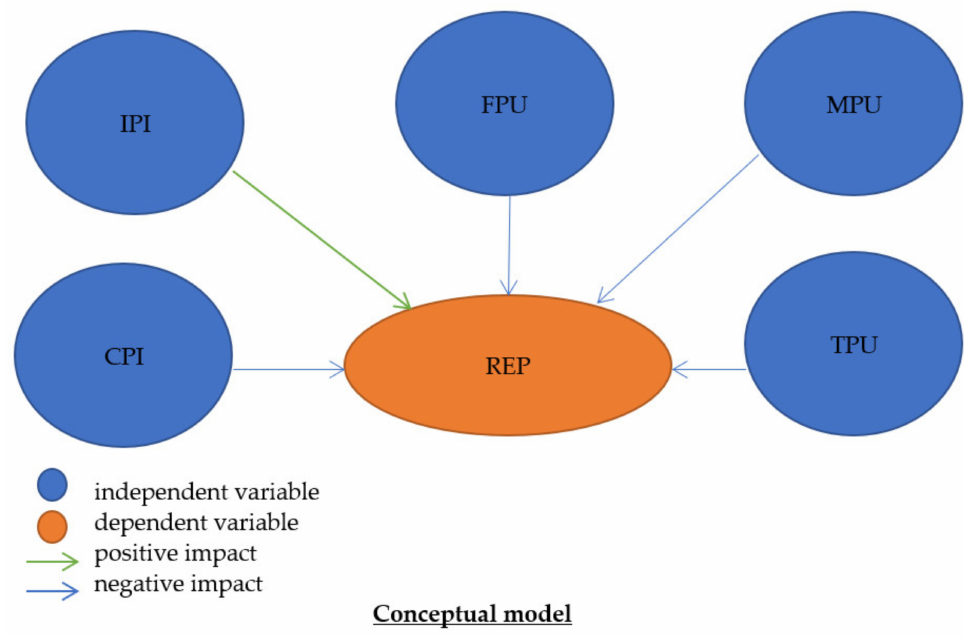
Figure 4. Conceptual